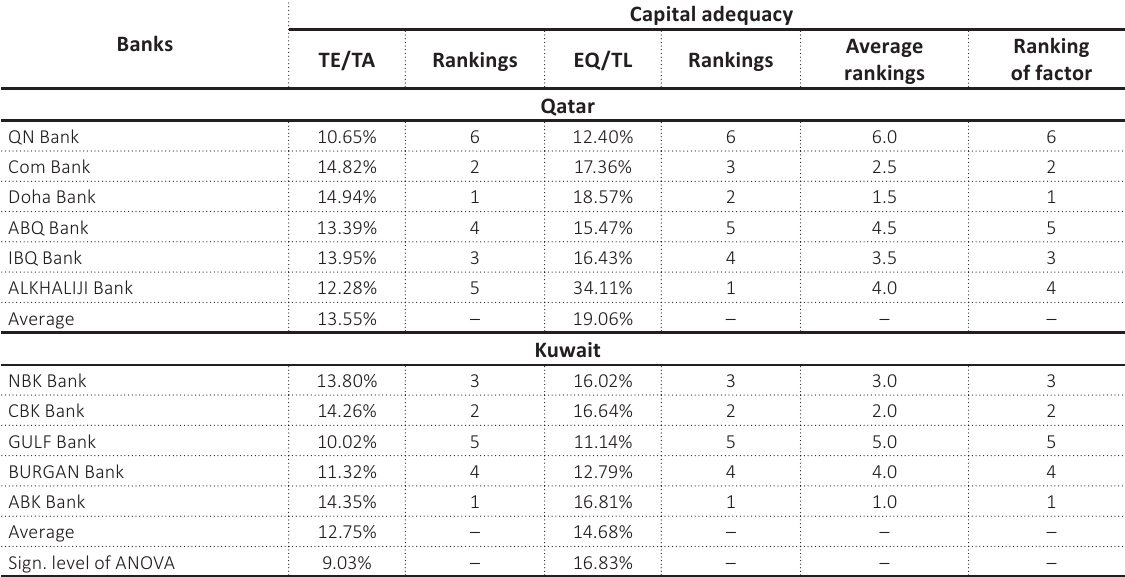
Table 3. Average ratios of years and rankings in the case of the Capital adequacy factor in selected